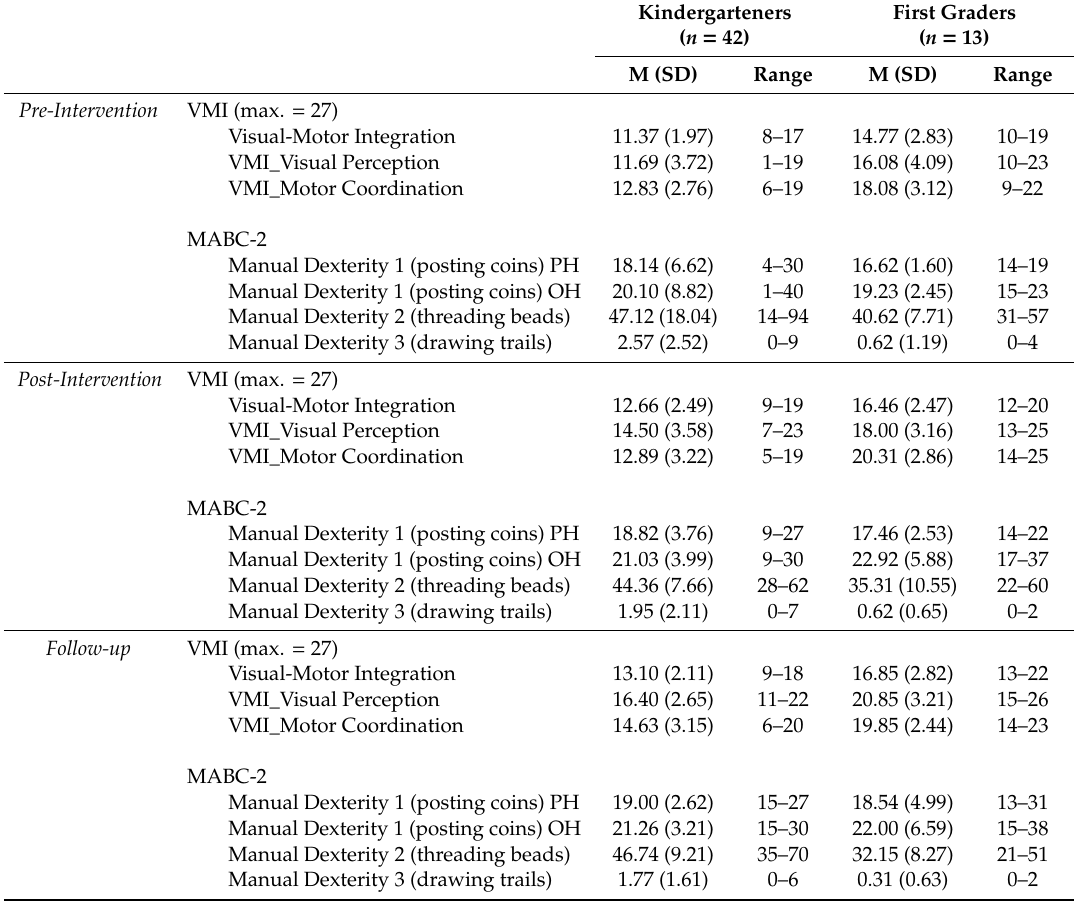
Table 2. Means and SD of the raw performance scores of the Visual-Motor Integration Test (VMI) and Movement Assessment Battery for Children-2 (MABC-2) assessed at the pre-intervention (T1), post-intervention (T2) and follow-up